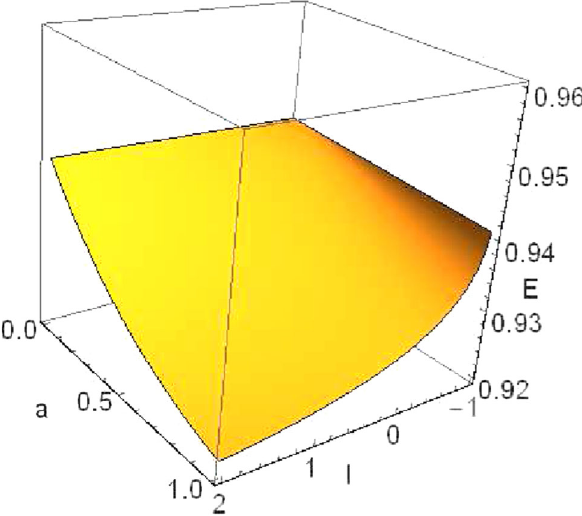
Fig. 1 The equivalent surface of the circular orbit radius r 0 = 6 . 5 in the parameter space ( a , l , E ) in the rotating black hole spacetime (4) in Einstein-bumblebee theory. Here we set M =